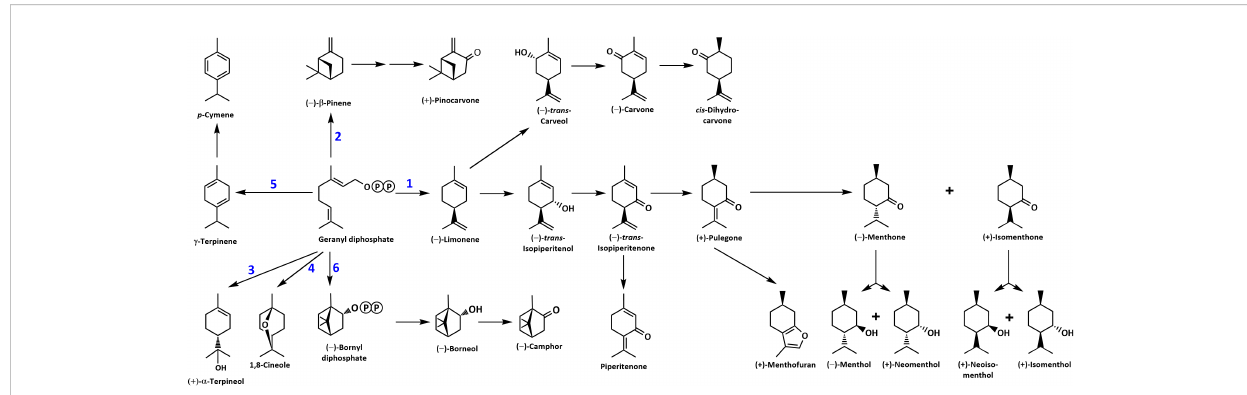
FIGURE 1 Overview of the mint monoterpene biosynthetic pathway. The circled letter P denotes a phosphate moiety. Reactions catalyzed by MTSs are numbered: 1, ( – )-limonene synthase; 2, ( – )- b -pinene synthase; 3, ( – )- a -terpineol synthase; 4, 1,8-cineole synthase; 5, g -terpinene synthase; and 6, ( – )-bornyl diphosphate